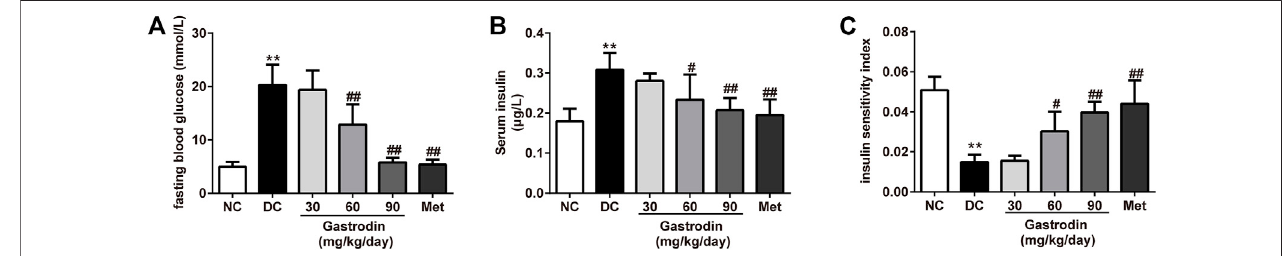
FIGURE 2 | The effects of Gastrodin on blood glucose levels, FINS and insulin sensitivity index in T2DM rats. Fasting blood glucose level (A) , Serum insulin concentration (B) and insulin sensitivity index (ISI) of each group (C) . The results were presented as mean ± SD ( n (cid:1) 6). ** p < 0.01, vs. NC group, # p < 0.05, ## p < 0.01, vs. DC group.